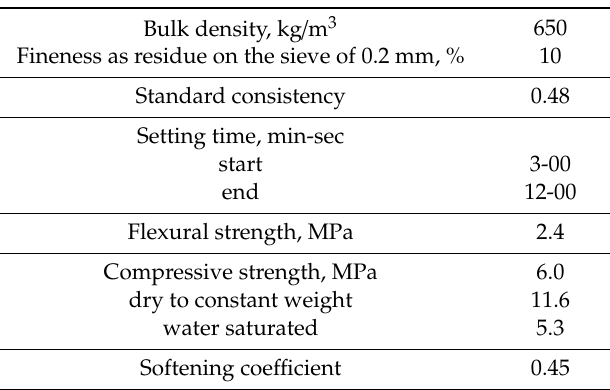
Table 2. Characteristics of the gypsum